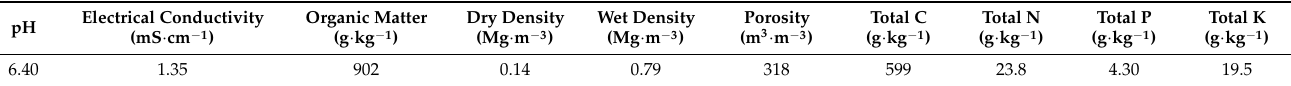
Table 2. Physical and chemical properties of the organic mulch from Shanghai Moqi Garden Co.,